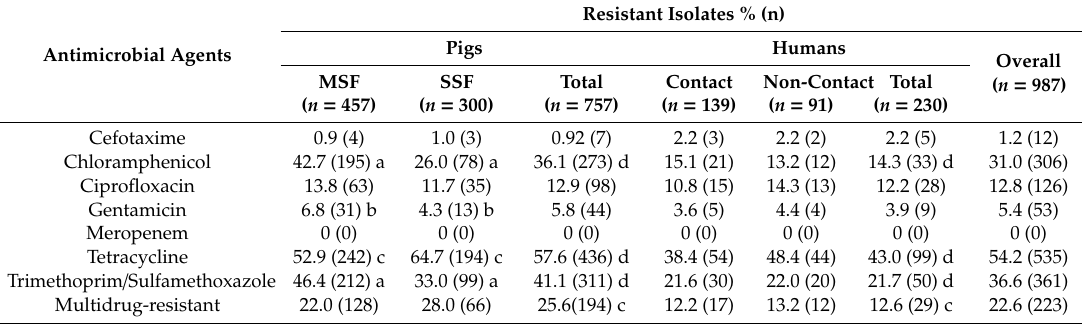
Table 1. Percentages and numbers of E. coli isolates from pigs and contact- and non-contact humans exhibiting resistance to various antimicrobial agents at medium-scale farms (MSFs) and small-scale farms (SSFs) in North-Eastern